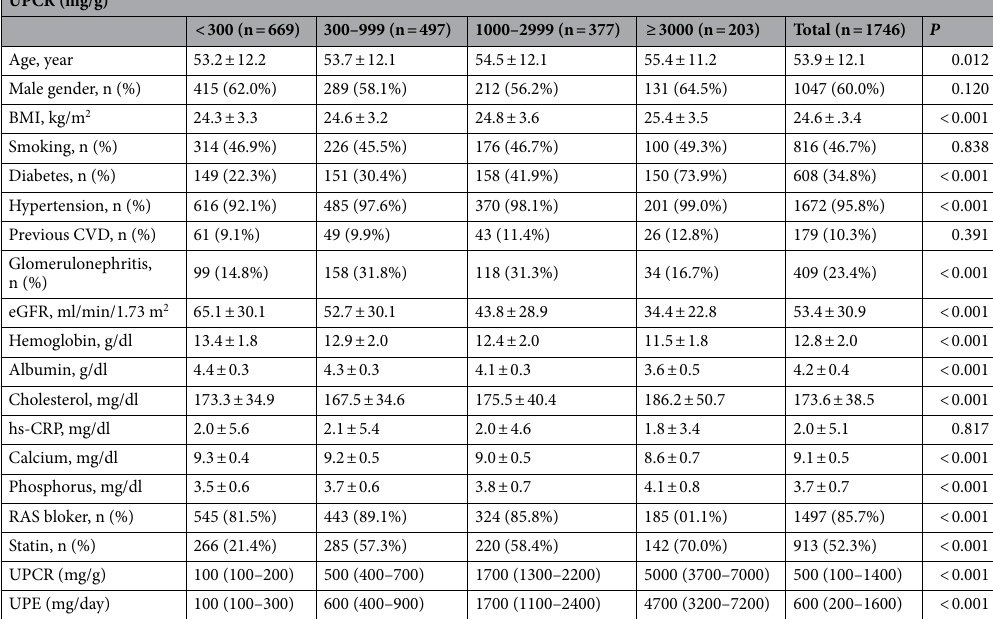
Table 1. Baseline characteristics of study participants. UPCR urine protein-creatinine ratio, BMI body mass index, CVD cardiovascular disease, RAS renin–angiotensin–aldosterone system; UPE, urine protein